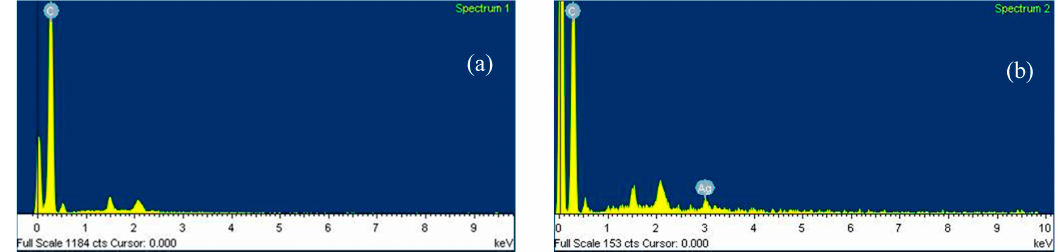
Figure 5. EDX image of ( a ) MWCNT and ( b ) MWCNT-Ag.